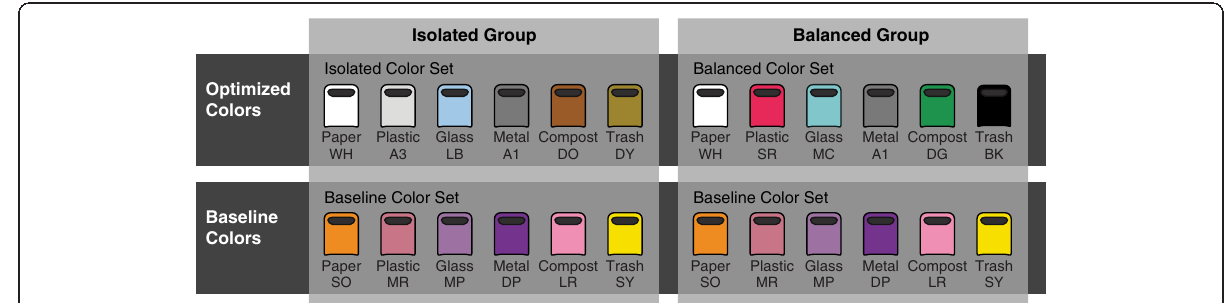
Fig. 7 The color conditions in Experiment 2. Participants were divided into two Optimized Color Set Groups (Isolated Group and Balanced Group). Each group saw two color sets, an optimized color set (isolated or balanced) and the baseline color